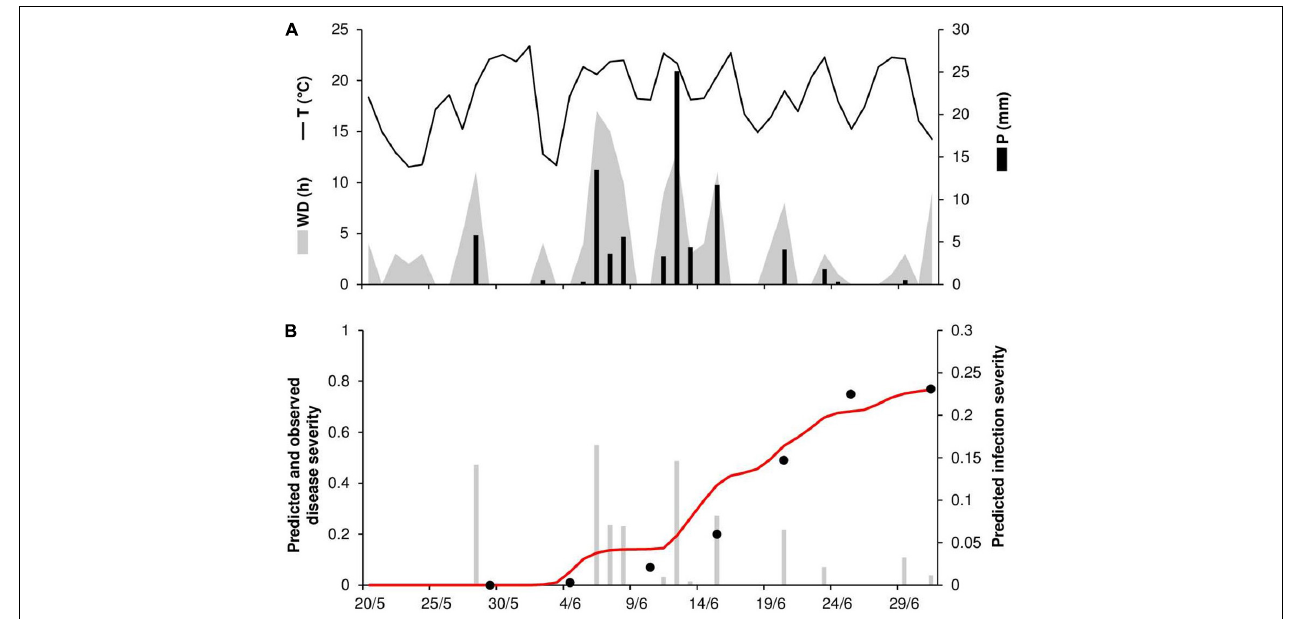
FIGURE 10 | Predicted and observed stem rust progress in the experimental wheat field (susceptible cv. Tyler) in Rock Springs, PA, United States, in 1986 (PEN86). (A) Weather variables: air temperature (T, ◦ C, solid line), rainfall (R, mm, black bars), and wetness duration (WD, in h, gray area). (B) Infection severity predicted by the model (gray bars), disease severity predicted by the model (red line), and observed disease severity (full dots).